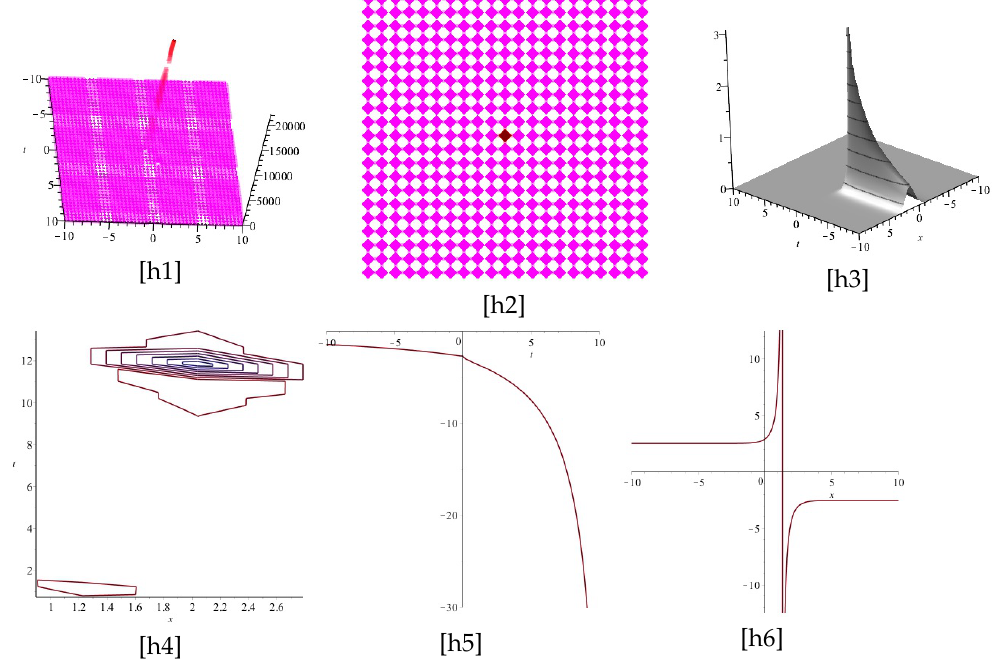
Figure 8. The plots of Equation (30), for λη < 0 and α = 0.25. Now, [h1] and [h3] are imaginary and real parts of Equation (30), and [h2], [h4], [h5], and [h6] display the z -axis orientation, the contour plot, the 2d for x = 2, and the 2d for t = 2, of the imaginary part of [h1],